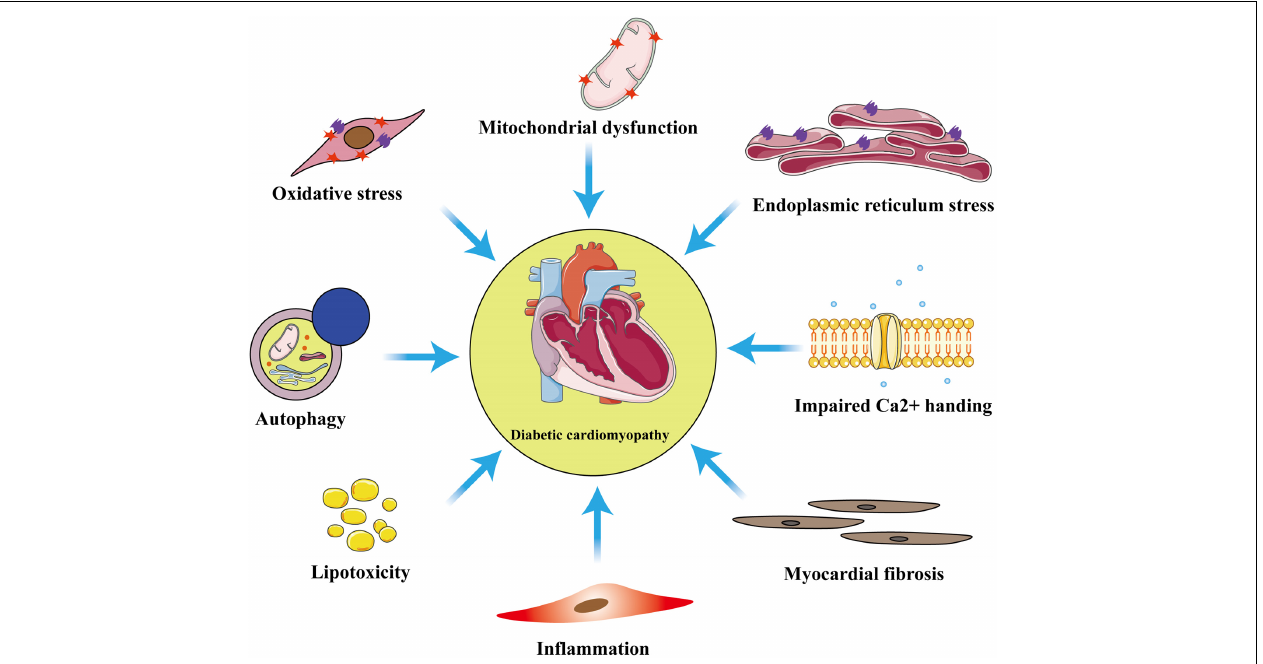
FIGURE 1 | Principal pathophysiological mechanisms in diabetic cardiomyopathy. The exact pathogenesis of diabetic cardiomyopathy (DCM) remains unclear, but numerous studies have shown that these pathological processes: inflammation, myocardial fibrosis, oxidative stress, mitochondrial dysfunction, endoplasmic reticulum stress, autophagy, lipotoxicity, and impaired calcium homeostasis are involved in the development of DCM.